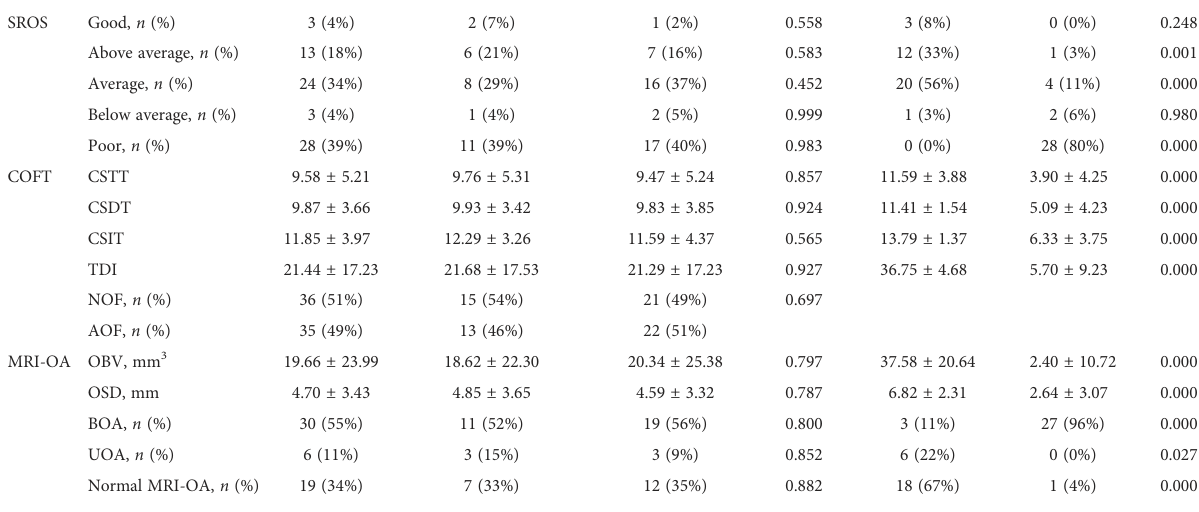
TABLE 2 The olfactory function of CHH